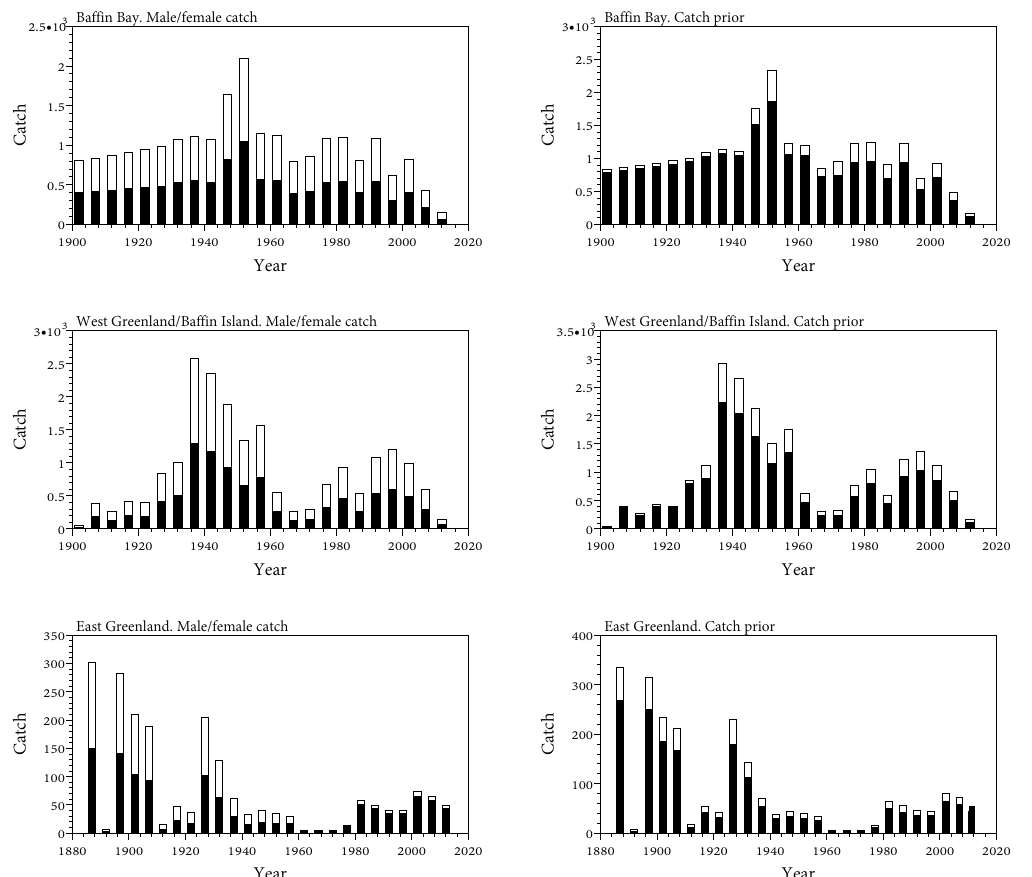
Fig. 1. For the three populations separately, the plots to the left show the historical catches of males (solid bars) and females (open bars) for the average catch history, and the plots to the right show the prior range in total catches (minimum by solid bars; maximum by open